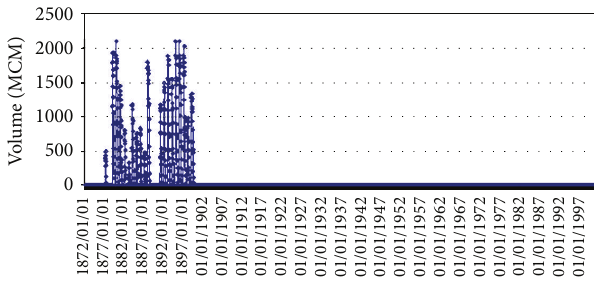
Figure 11: Overflow time series for TD configuration